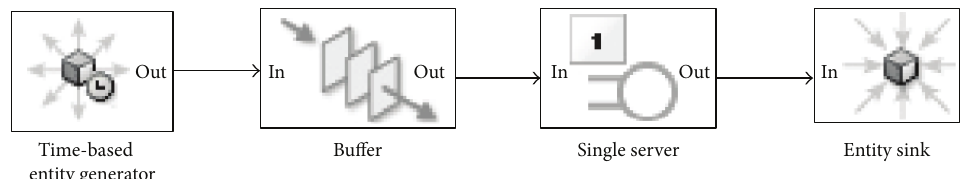
Figure 3: The simulation model.